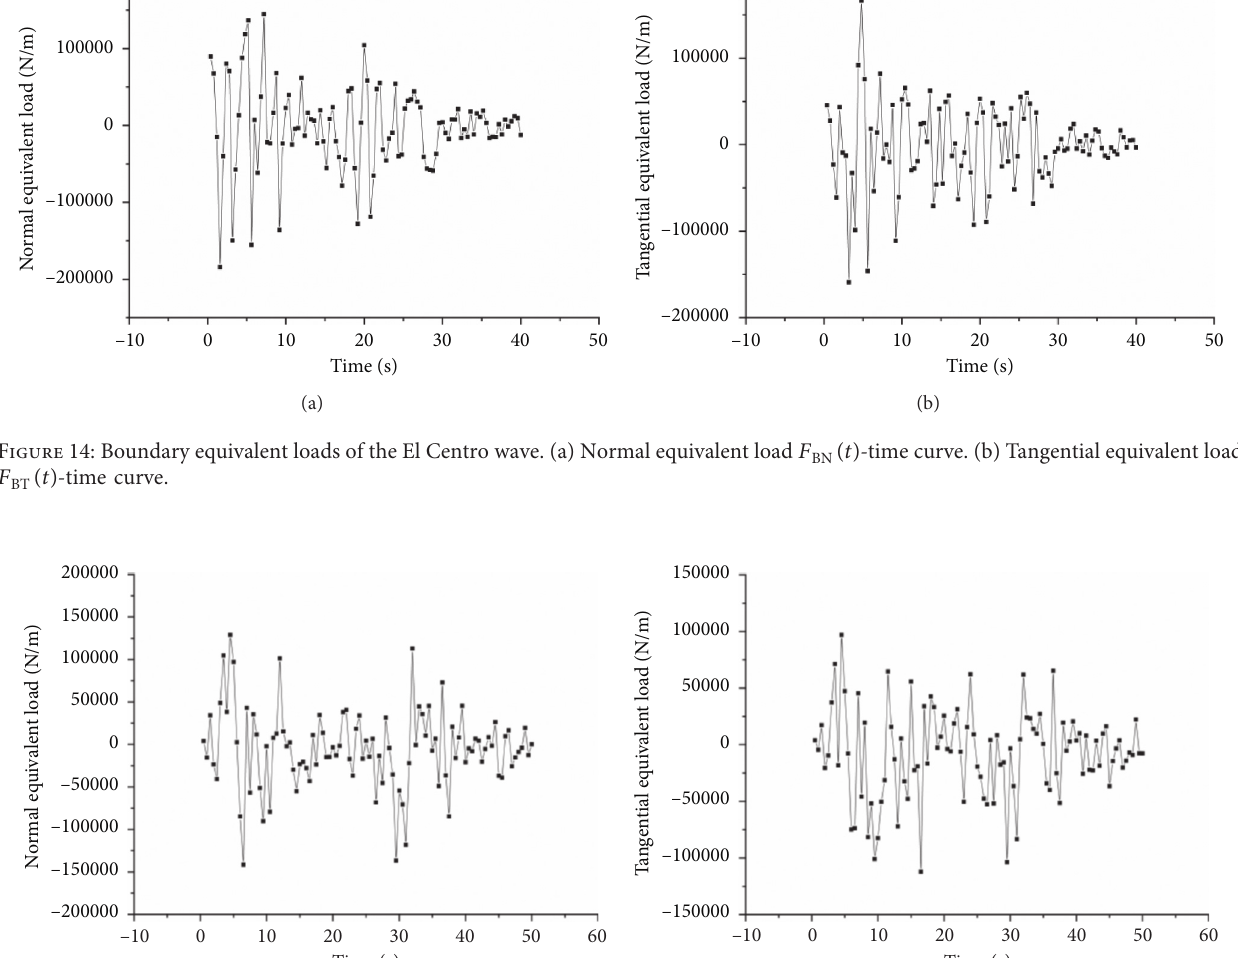
( t ) -time curve. (b) Tangential equivalent load BN